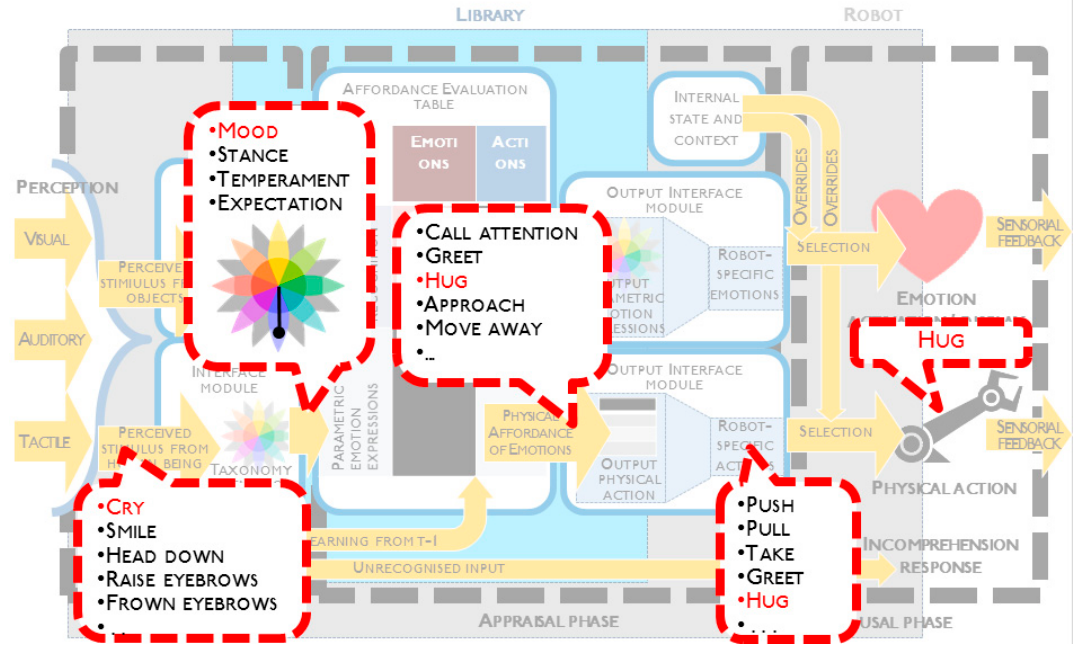
Figure 8. Summary of the object-to-emotion affordance process.